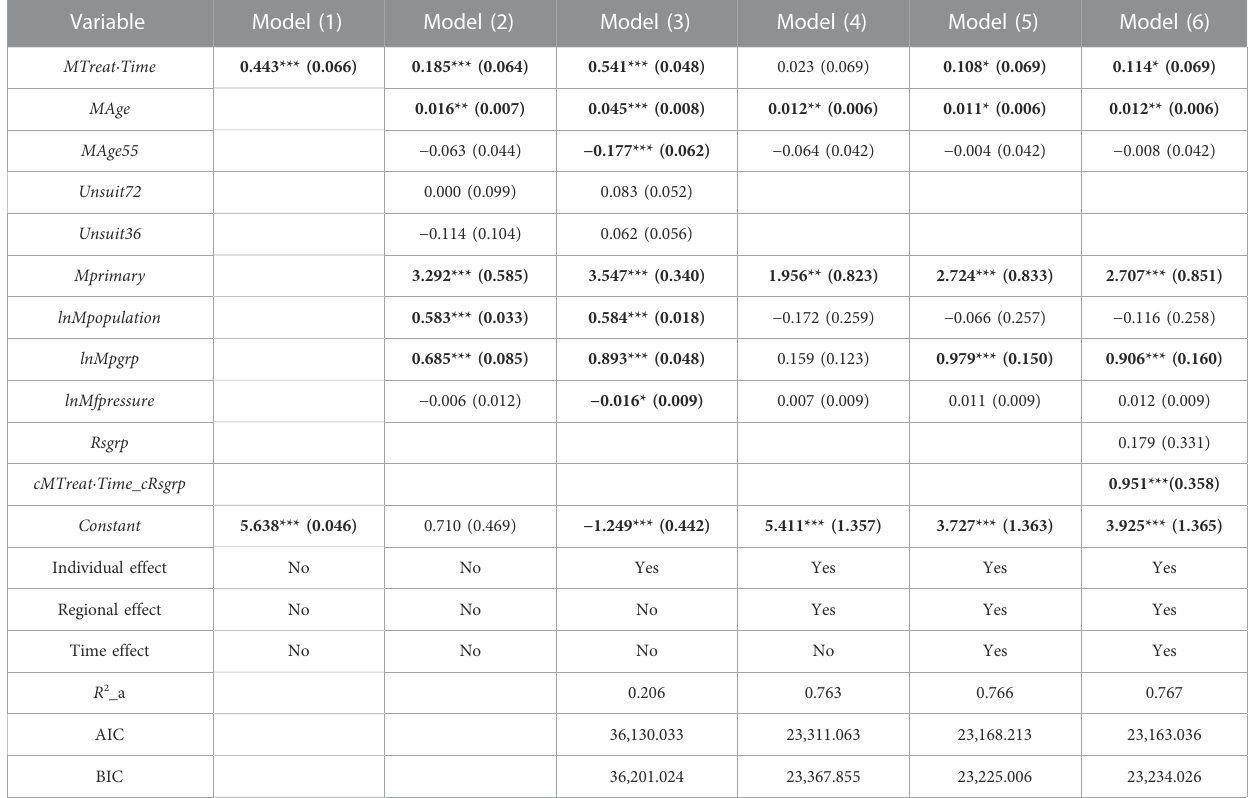
TABLE 2 Estimation results of leading cadre ’ s favoritism on protected agriculture expansion decisions.